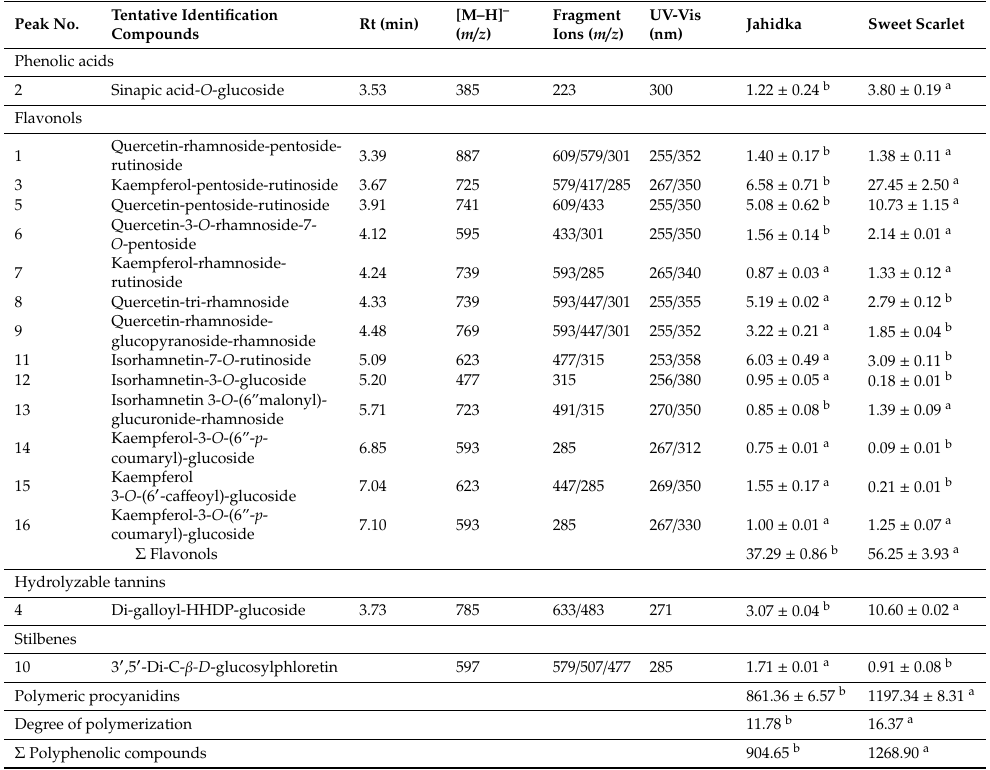
Table 2. Summary of qualitative and quantitative data of the polyphenolic profile in fruits of E. multiflora